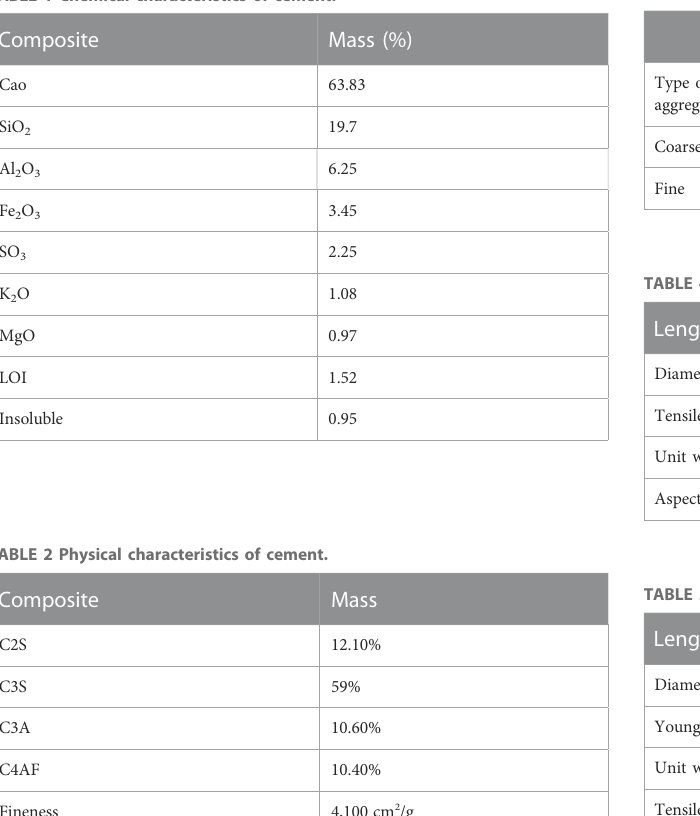
TABLE 3 Physical characteristics of the aggregates.